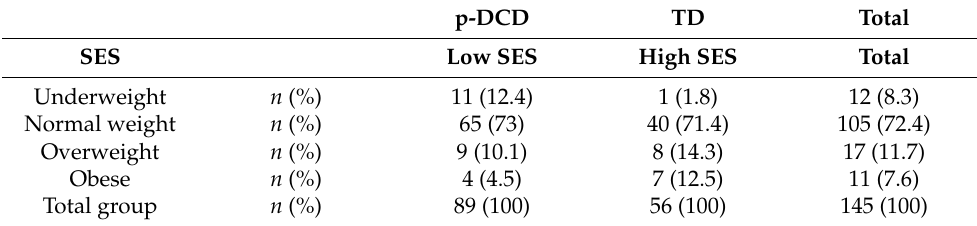
Table 4. Frequency table of participants regarding SES and BMI categories.